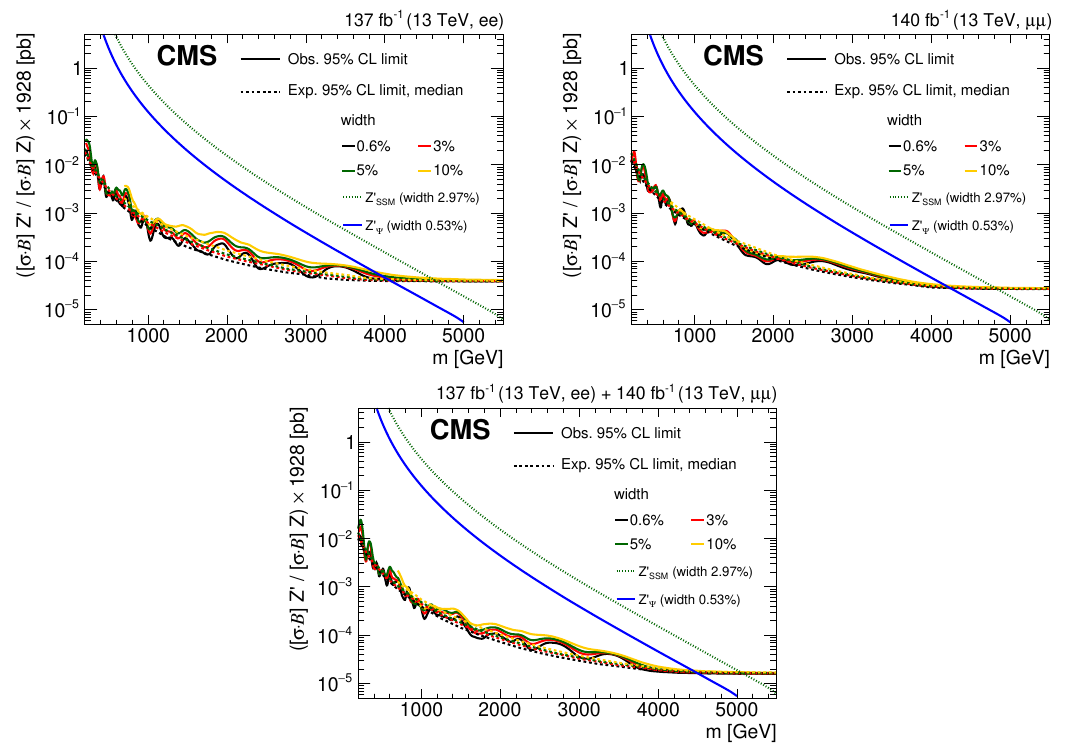
Figure 5 . The upper limits at 95% CL on the product of the production cross section and the branching fraction for a spin-1 resonance, for widths equal to 0.6, 3, 5, and 10% of the resonance mass, relative to the product of the production cross section and the branching fraction for a Z boson, multiplied by the theoretical value of σ (pp → Z+ X → ‘‘ + X ) of 1928 pb, for (upper left) the dielectron channel, (upper right) the dimuon channel, and (lower) their combination. Theoretical predictions for the spin-1 Z 0 and Z 0 resonances are also SSM ψ